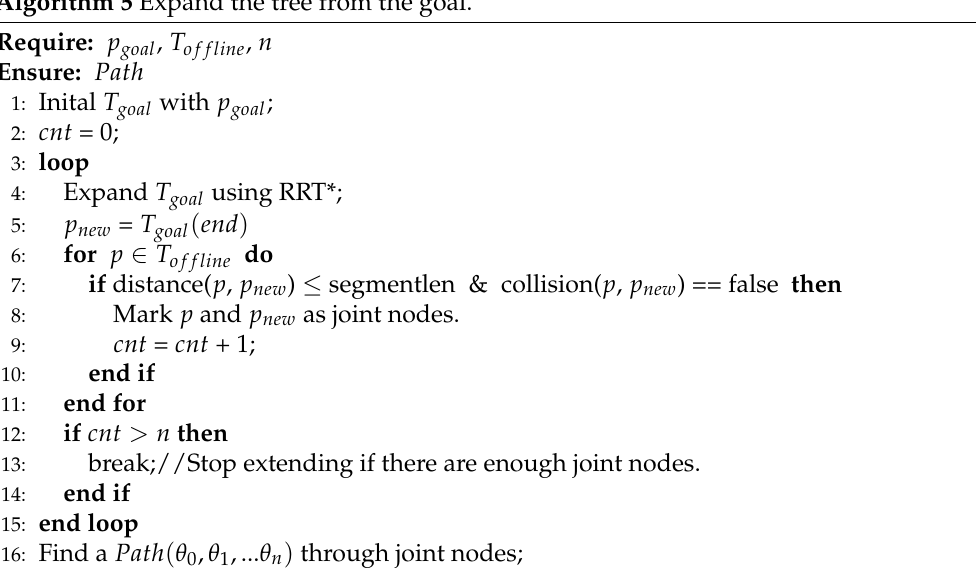
Algorithm 5 Expand the tree from the